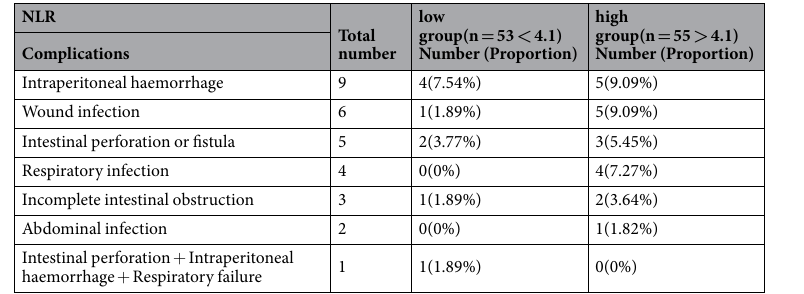
Table 7. The incidence of seven complications in the low and high NLR